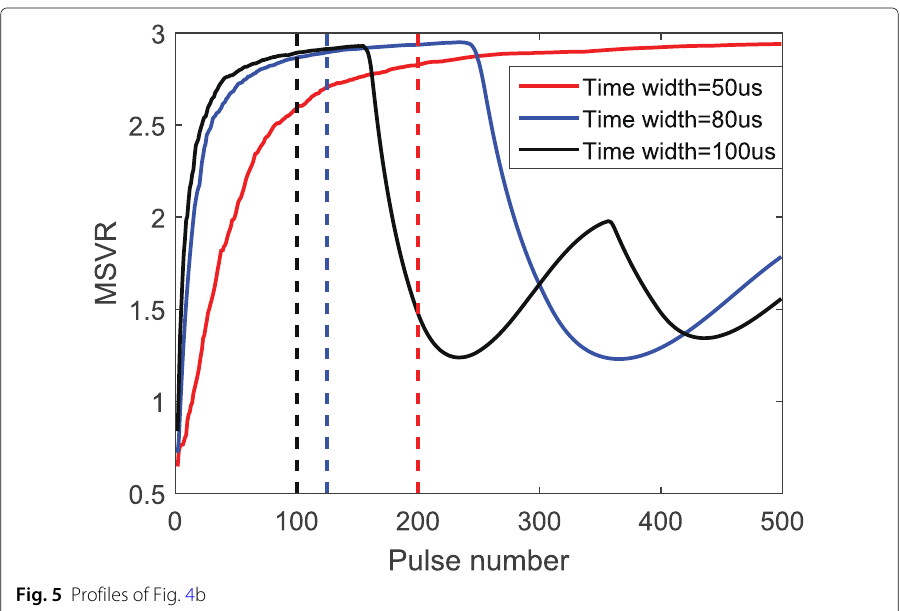
Fig. 5 Profiles of Fig. 4b